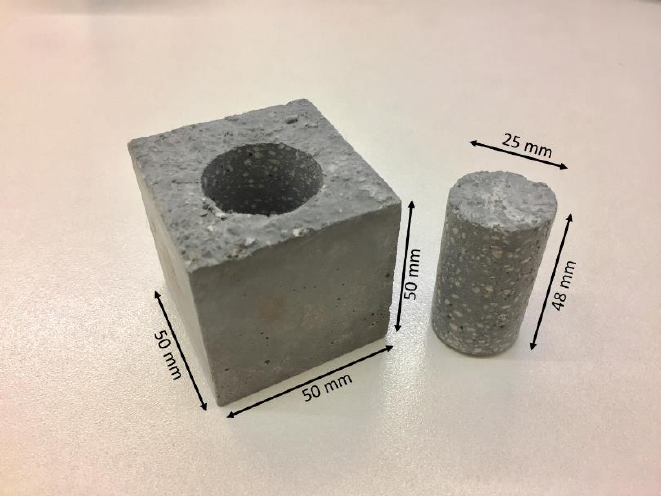
Figure 3. Illustration of sample preparation via coring for CT scan testing.